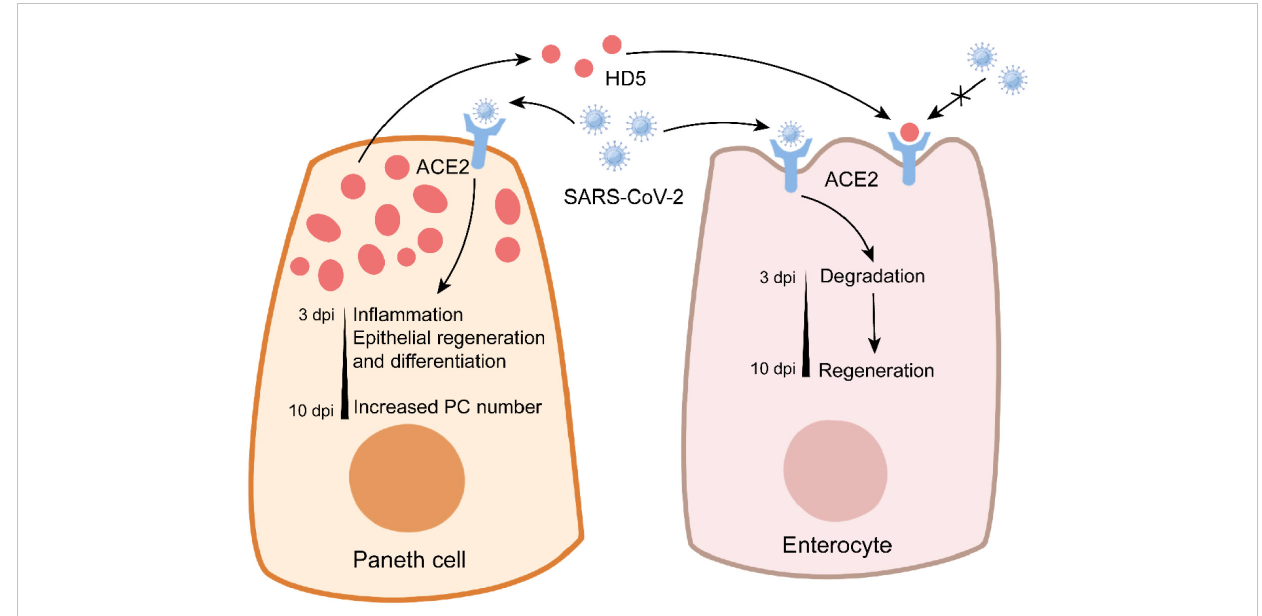
FIGURE 4 Paneth cells in COVID-19. In Paneth cells, SARS-CoV-2 infection triggers the expression of genes related to in fl ammation and epithelial repair, and it enhances the number of Paneth cells at later stage. In enterocytes, SARS-CoV-2 infection leads to the conversion from degradation to regeneration over time. Notably, Paneth cell-derived HD5 binds to ACE2 to prevent SARS-CoV-2